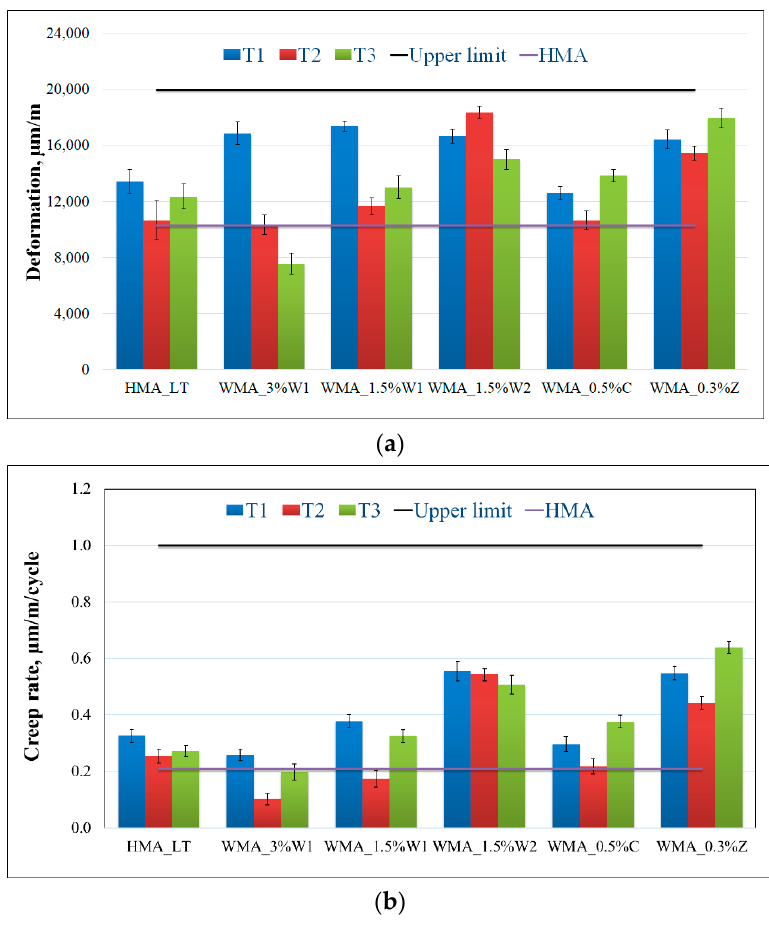
Figure 8. Triaxial cyclic compression test results: ( a ) deformation; ( b ) creep rate (length of the error bar is equal to one standard deviation).